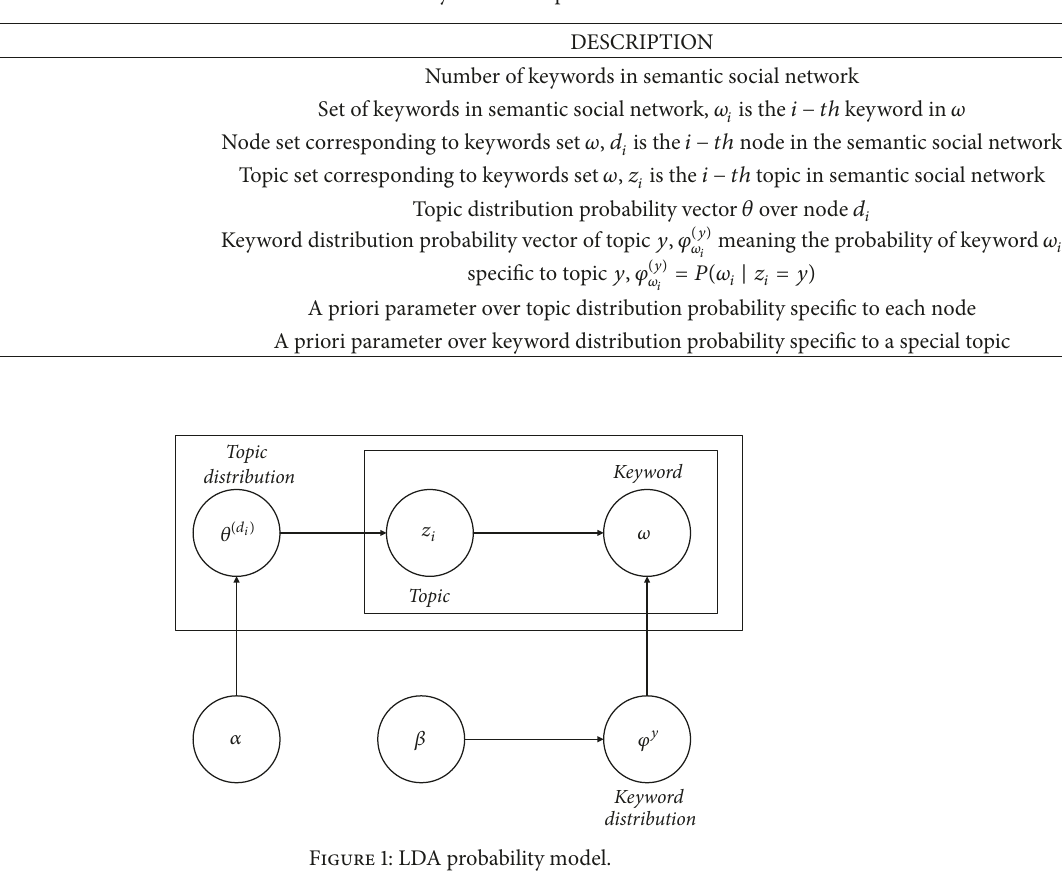
Table 1: The symbol description.